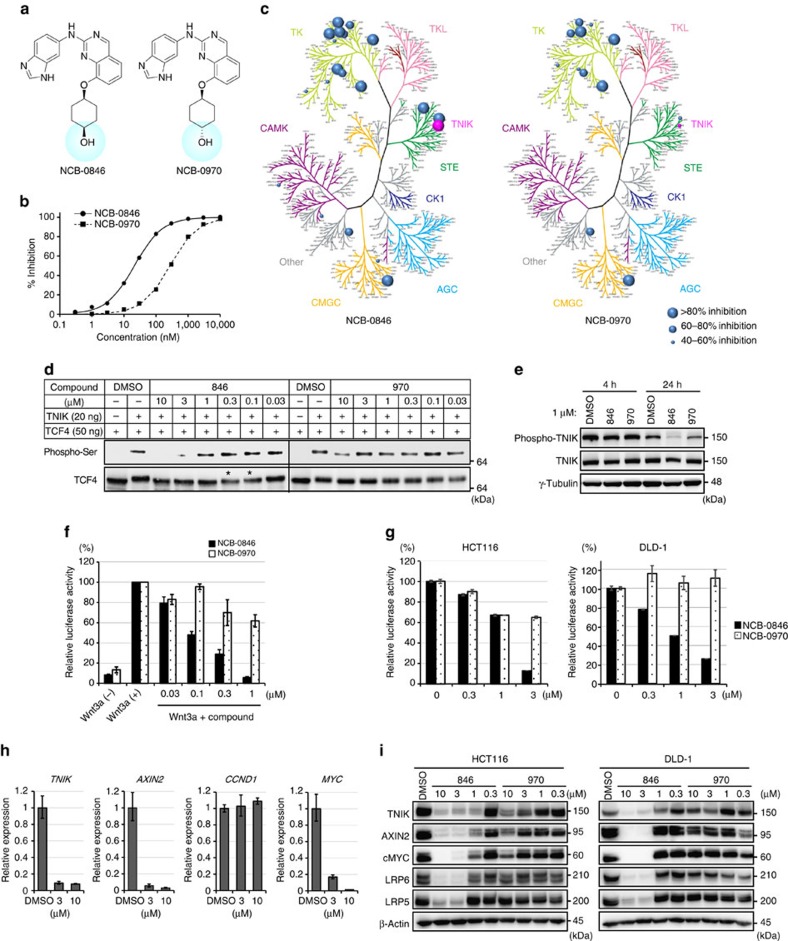
Identification of a novel TNIK inhibitor.(a) Structure of NCB-0846 (left) and its diastereomer NCB-0970 having the opposite configuration at the terminal hydroxyl group (right). (b) Inhibition of TNIK enzyme activity by the indicated concentration of NCB-0846 or NCB-0970. (c) Inhibitory profiles of NCB-0846 and NCB-0970 across the human kinome. The degree of inhibition is presented schematically by the size of the circles. (d) Inhibition of TCF4 phosphorylation by NCB-0846. The recombinant human TCF4 protein was incubated with the recombinant human TNIK protein in the presence of the indicated concentration of NCB-0846 or NCB-0970 and analysed by immunoblotting. (e) Inhibition of TNIK auto-phosphorylation by NCB-0846. HCT116 cells were cultured in the presence of DMSO (vehicle), 1 μM NCB-0846, or 1 μM NCB-0970 for 4 or 24 h and then analysed by immunoblotting with anti-phosphorylated TNIK, anti-TNIK, and anti-γ-tubulin (loading control) antibodies. (f) Suppression of TCF/LEF transcriptional activity by NCB-0846. HEK293 cells were transfected with pGL4.49[luc2P/TCF-LEF-RE/Hygro] and then treated with the indicated concentration of NCB-0846 or NCB-0970 for 24 h. The cells were then incubated with or without recombinant Wnt3a (10 ng ml−1) for 5 h before measurement of luciferase activity. Data are represented as ratios relative to the DMSO control (set at 100%)±s.e.m. (g) HCT116 (left) and DLD-1 (right) cells were transfected with one of the luciferase reporter plasmids (SuperTOP-flash or SuperFOP-flash) and then treated with 20 mM LiCl and the indicated concentration of NCB-0846 or NCB-0970 for 24 h. Data are presented as the ratios of SuperTOP-flash to SuperFOP-flash (TOP/FOP ratio). Error bars represent s.d. (h) HCT116 cells were treated with DMSO (control) or the indicated concentration of NCB-0846. Twenty-four hours later, the expression levels of the TNIK, AXIN2, CCND1 and MYC genes (normalized to ACTB) were quantified in triplicate by RT–PCR. The values of cells treated with DMSO were set to one. Error bars represent s.d. (i) HCT116 and DLD-1 cells were treated with DMSO (vehicle) or the indicated concentration of NCB-0846 or NCB-0970 for 48 h. The expression of TNIK, AXIN2, c-MYC, LRP6, LRP5 and β-actin (loading control) proteins was analysed by immunoblotting.